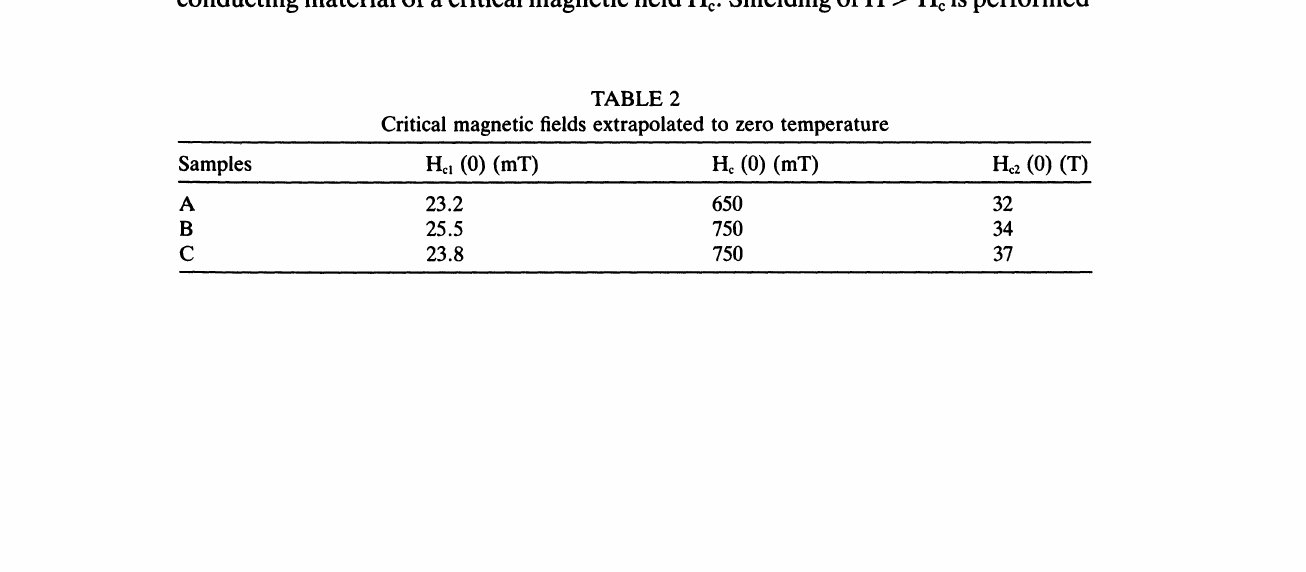
Critical magnetic fields extrapolated to zero temperature